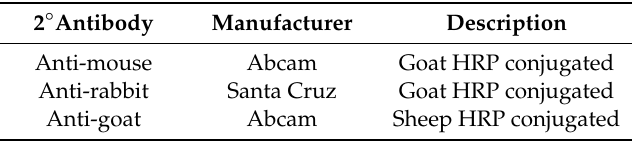
Table 2. Secondary antibodies utilized for western blotting.